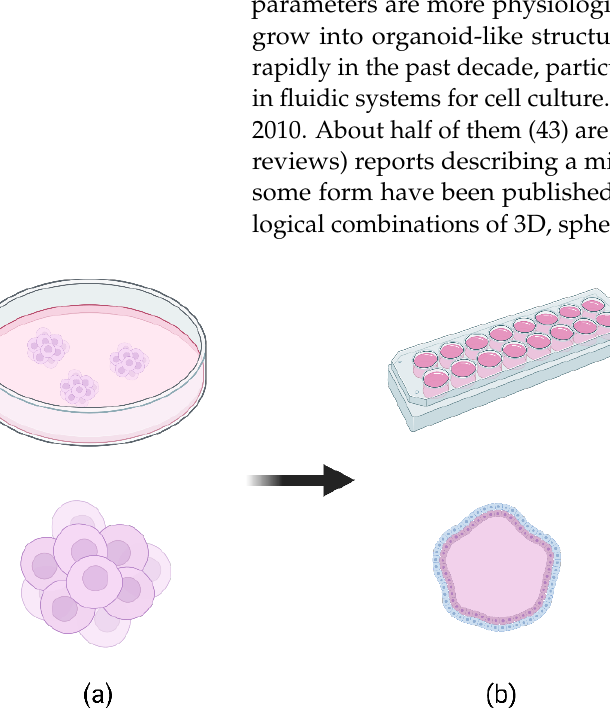
Figure 1. Representation to show the development of advanced in vitro systems: ( a ) spheroids, clusters of single cells or aggregates grown without a cellular scaffold in low attachment plates; ( b ) trophoblast organoid grown in 3D using Matrigel; ( c ) a simple placenta-on-a-chip (PoC) model where two microfluidic channels are separated by a semipermeable membrane or scaffold. Created with BioRender.com.